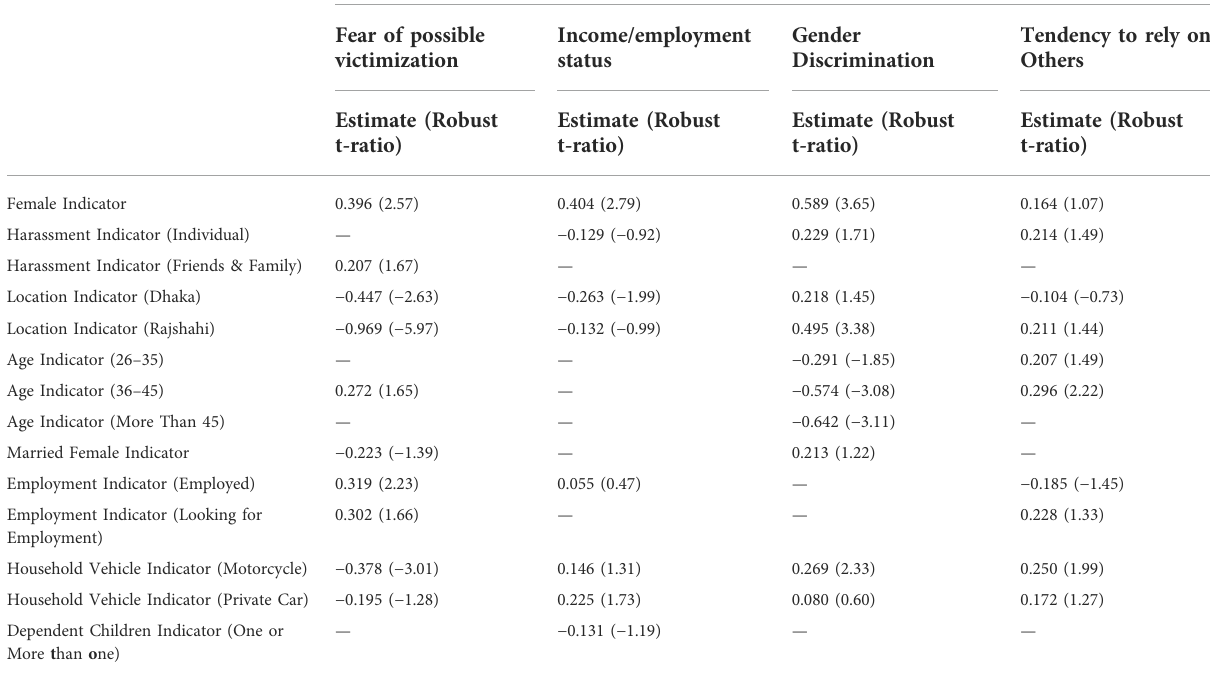
TABLE 3 Ordered probit model results on perception of women ’ s